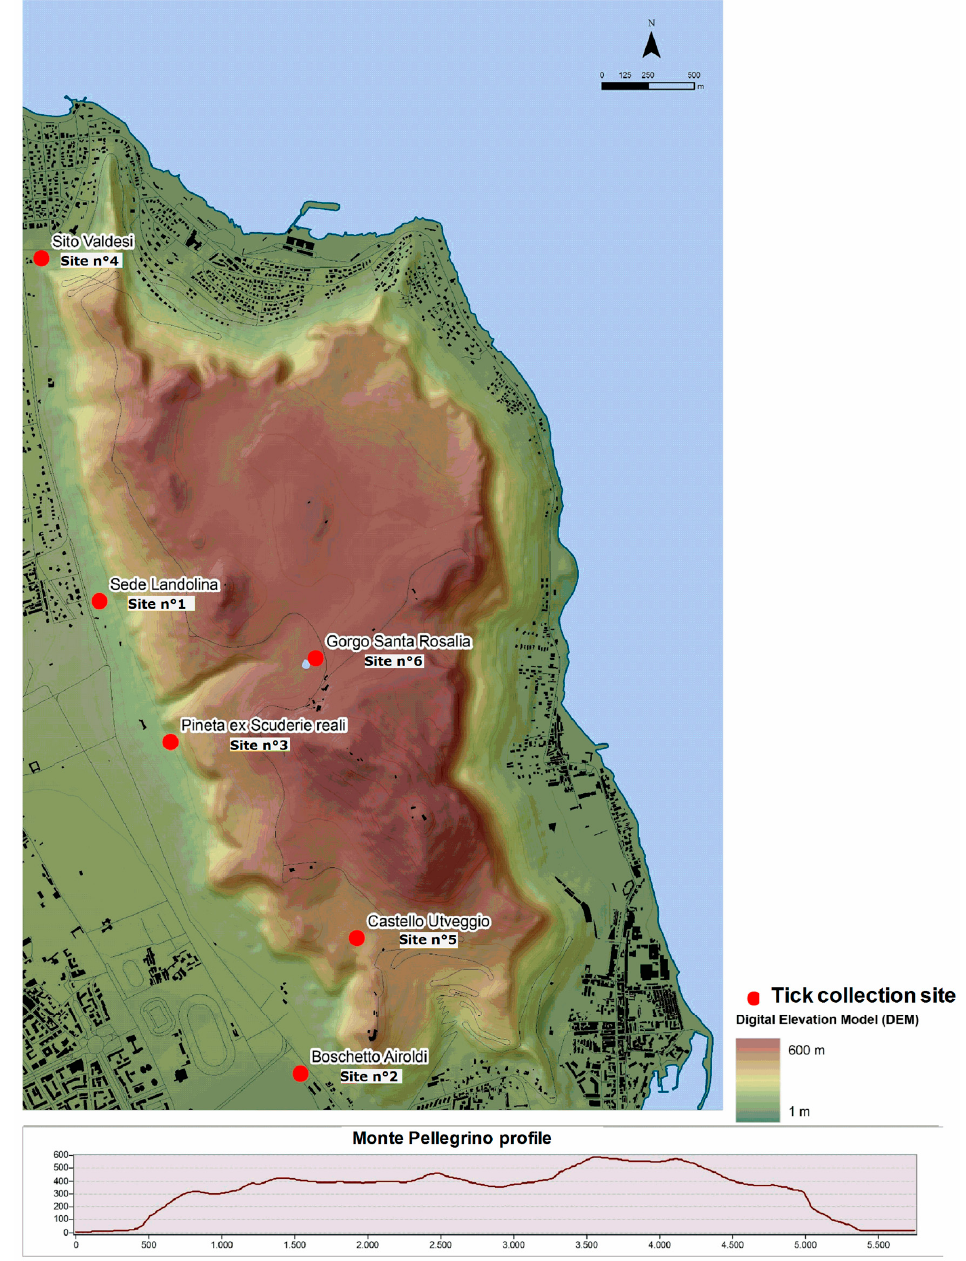
Figure 4. Digital Elevation Model (above) and Profile of Monte Pellegrino (below).